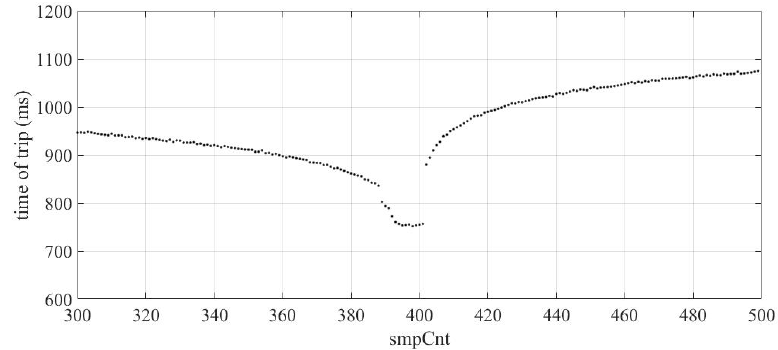
Figure 21. Tripping time results ANSI 51 — smpCnt manipulation of SV packets.